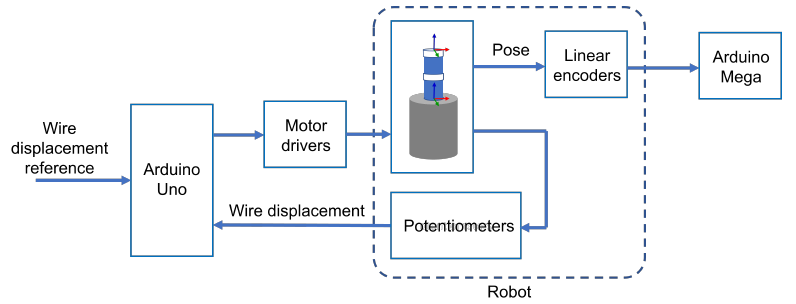
Figure 13. Schematics of the signal flow between hardware